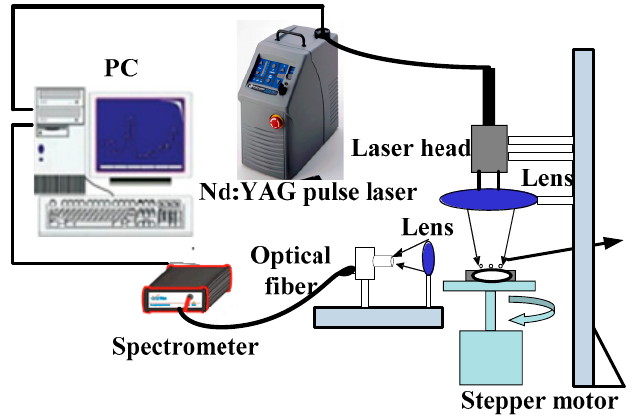
Figure 1. Schematic of LIBS experimental system.